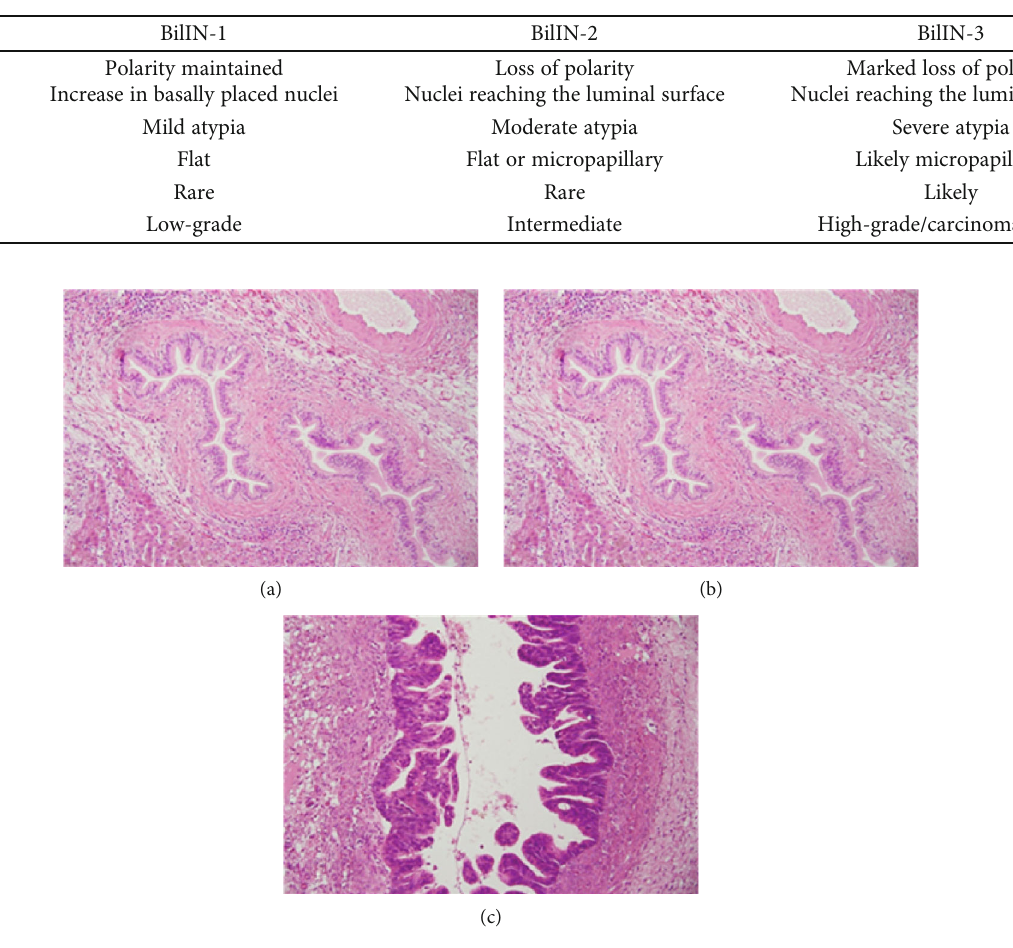
Figure 1: Histology image of biliary cancer precursors. (a) Biliary intraepithelial neoplasia grade 1 (BilIN-1) — bile duct with tall columnar cells with mild nuclear abnormalities. (b) Biliary intraepithelial neoplasia grade 2 (BilIN-2) — bile duct with columnar cells with moderate nuclear abnormalities and focal pseudopapillary or micropapillary architecture of the epithelium. (c) Biliary intraepithelial neoplasia grade 3 (BilIN-3) — bile duct with columnar cells with severe nuclear abnormalities and pseudopapillary and cribriform architecture of the epithelial layer. Haematoxylin-eosin staining (courtesy of Dr. Jana